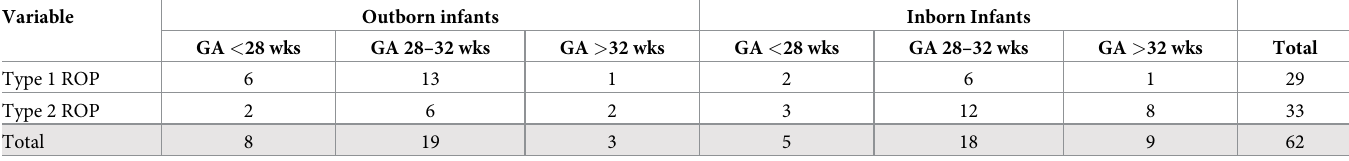
Table 4. Characteristics of 62 cases of ROP by type of ROP and place of birth. Variable